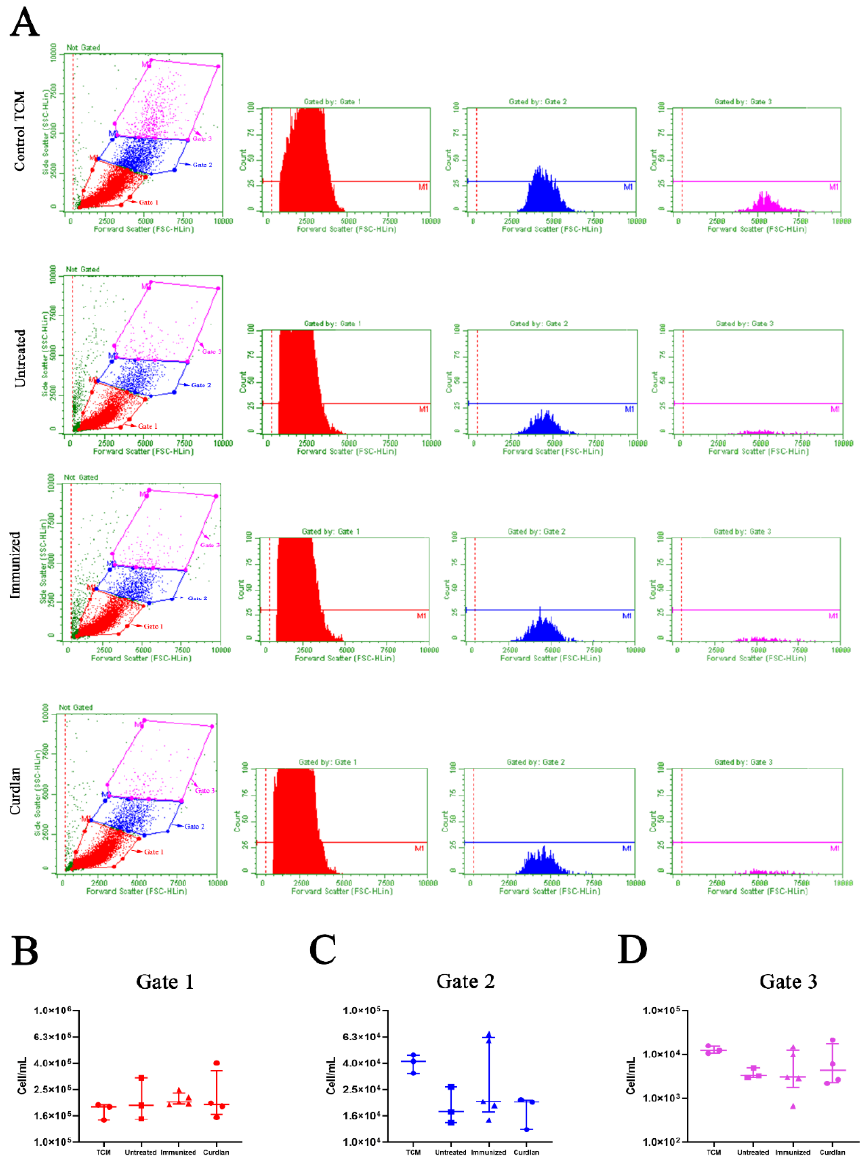
Figure 3. Evaluation of the size and concentration of C. gattii cultured in TCM in the presence of serum from BALB/c mice treated with the adjuvant curdlan. The BALB/c mice received curdlan or PBS and were immunized with HK- C. gattii -thin, before being challenged with C. gattii . After 14 days of infection, the serum was collected and incubated with C. gattii cultured in TCM. After 24 h of incubation, the C. gattii cells were analyzed by flow cytometry. The size and concentration of the three populations of C. gattii cells, as delimited by gates 1 (red; ( A , B )), 2 (blue; ( A , C )), and 3 (pink; ( A , D )), were measured. The FSC-HLin was the parameter used to normalize the size among the groups to express the cell concentration (cell/mL). Results are expressed as medians with interquartile